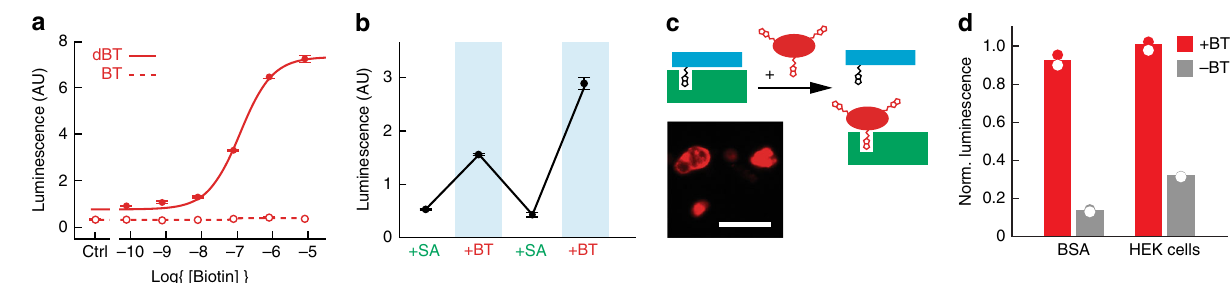
Fig. 3 Validation of BT-AVATar in vitro. a Titration of BT-AVATar containing dBT-modi fi ed PACAP (solid line) showing activation with EC 50 of 120 ± 10 nM. An equivalent variant of the sensor containing BT-modi fi ed PACAP (dashed line) is not activated by biotin. b Biotin vasosensor activity over repeated cycles of excess SA and biotin (BT) addition. c Schematic showing AVATar activation by biotinylated proteins or cells (red). Inlay shows biotinylated HEK cells stained with fl uorescent streptavidin. Scale bar = 50 µ m. Experiment was performed twice. d BT-AVATar is robustly activated by biotinylated bovine serum albumin and HEK cells (red) but not by unbiotinylated controls (gray). All error bars denote SD of